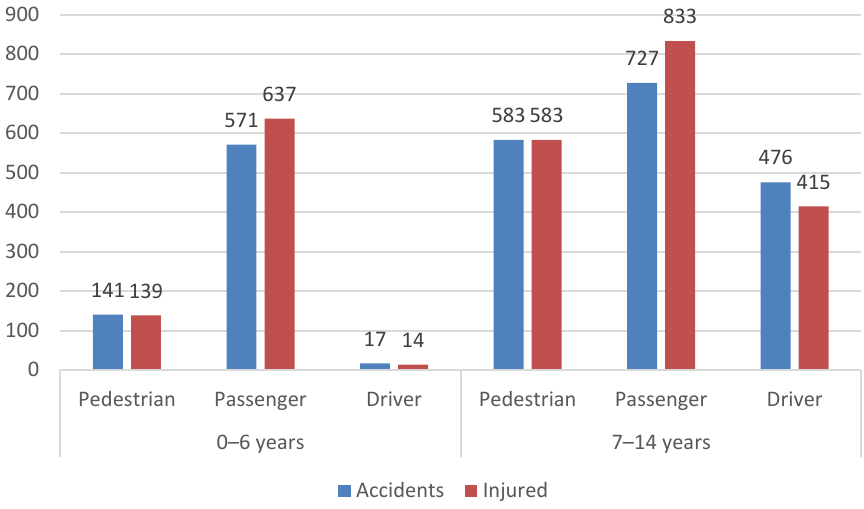
Figure 4. Road accidents by age group and role in 2019 in Poland. The greatest number of killed and injured children and adolescents is in the group of car passengers, followed by pedestrians, see Table 1. Based on the data [42] for 2019, 7005 accidents involved pedestrians. Unfortunately, 16% occurred in the 0–17 age group. Victims constituted 3% and the injured 17.3% of all incidents concerning the analysed age group. Among 1626 accidents involving cyclists in the analysed age group, there were 21.5% of events, including 9% fatalities and 22.2% children injured. Table 1. Road accidents with children as pedestrians and cyclists in 2019 in Poland. Group